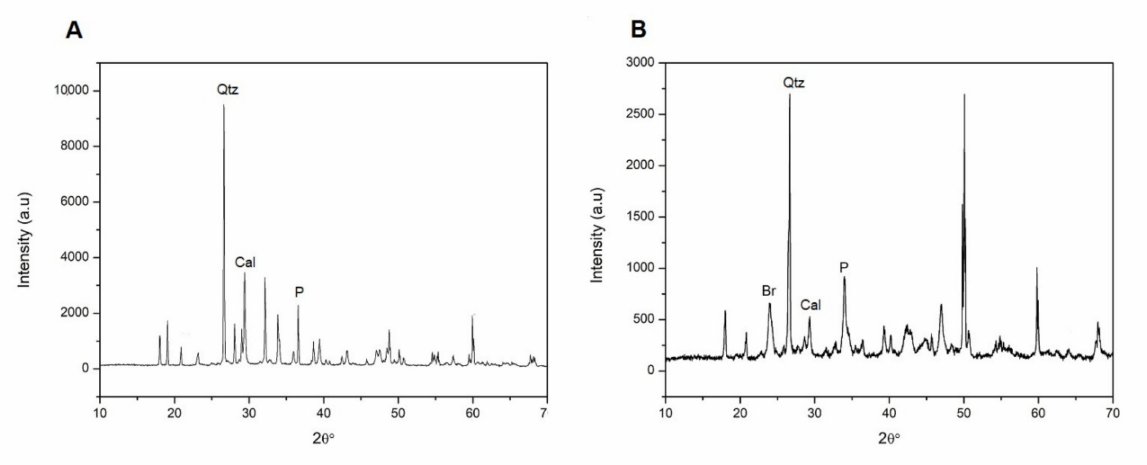
Figure 7. X-ray diffraction pattern of samples, after 90 days of curing. ( A ) Group In; ( B ) Group IIn, P: Portlandite, T: Thenardite, Cal: Calcite, Qtz: Quartz, Br: